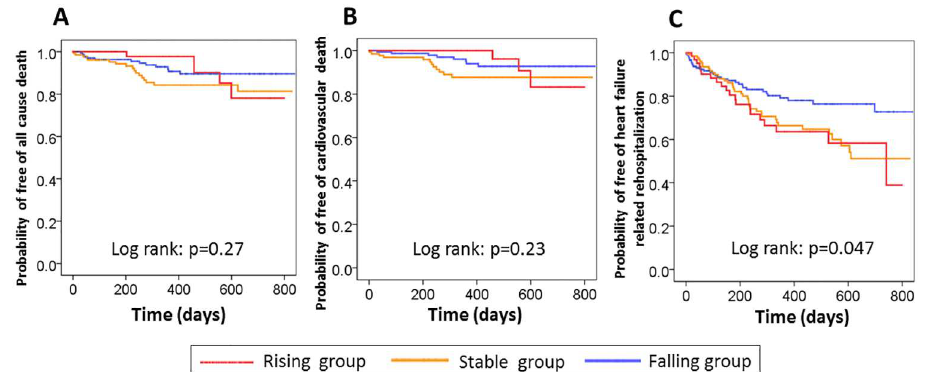
Fig 2. Comparison of Kaplan—Meier estimatesfor probability of (A) free of all cause death, (B) free of cardiovascular death, and (C) free of heart failure-related rehospitalization among the falling, stable, and rising groups. All cause death and cardiovascular death were not different amongthe falling, stable, and rising groups(Fig 2A, B). HF-related rehospitalization was significantly lower in falling group (p = 0.047; log- rank test; Fig